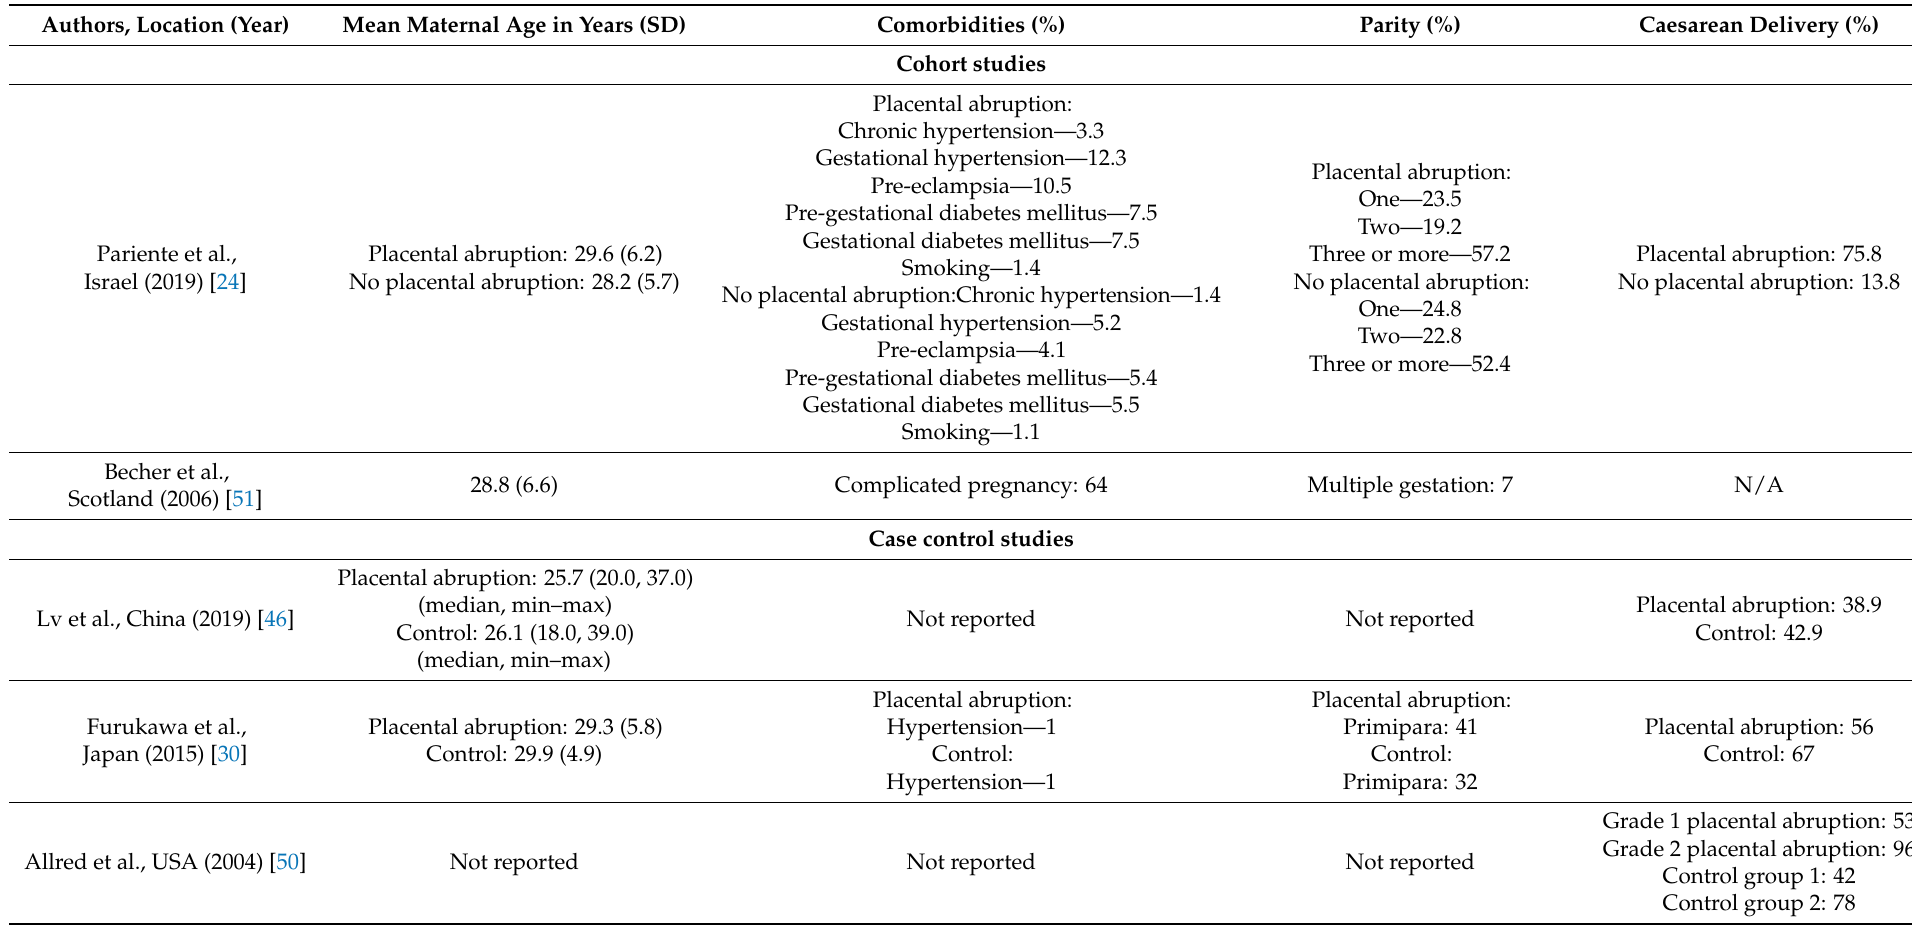
Table 2. Maternal characteristics of the study